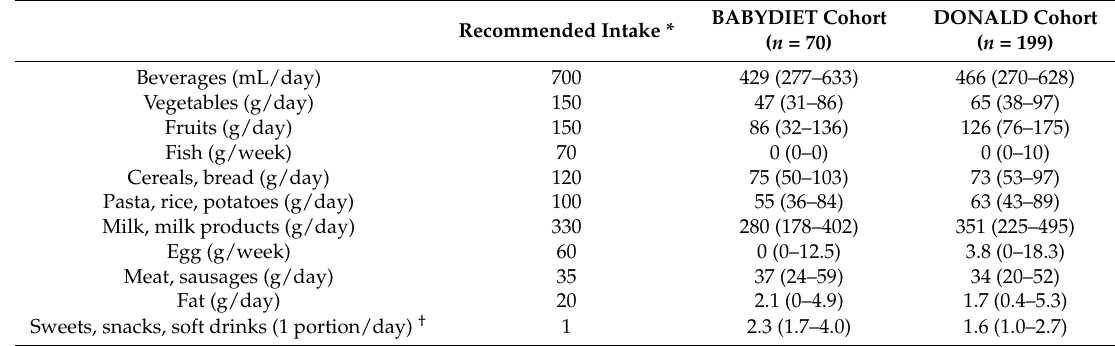
Table 4. Age-specific recommendations on daily food intake and the median intake of foods in children aged 24